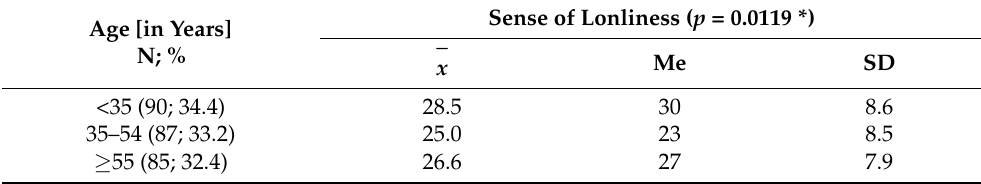
Table 5. A sense of loneliness in connection with age groups.